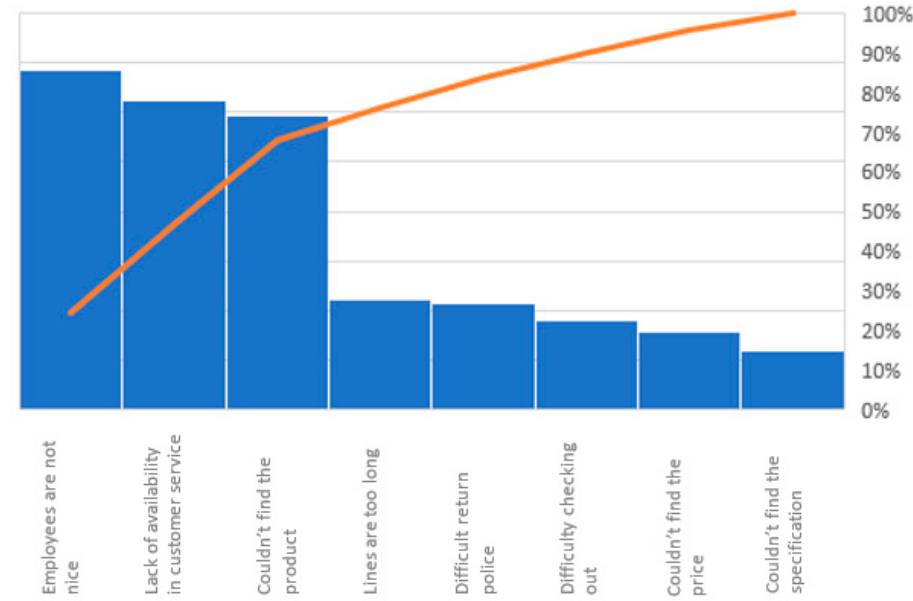
Figure 10. Example of Pareto analysis of Interview results (authors).